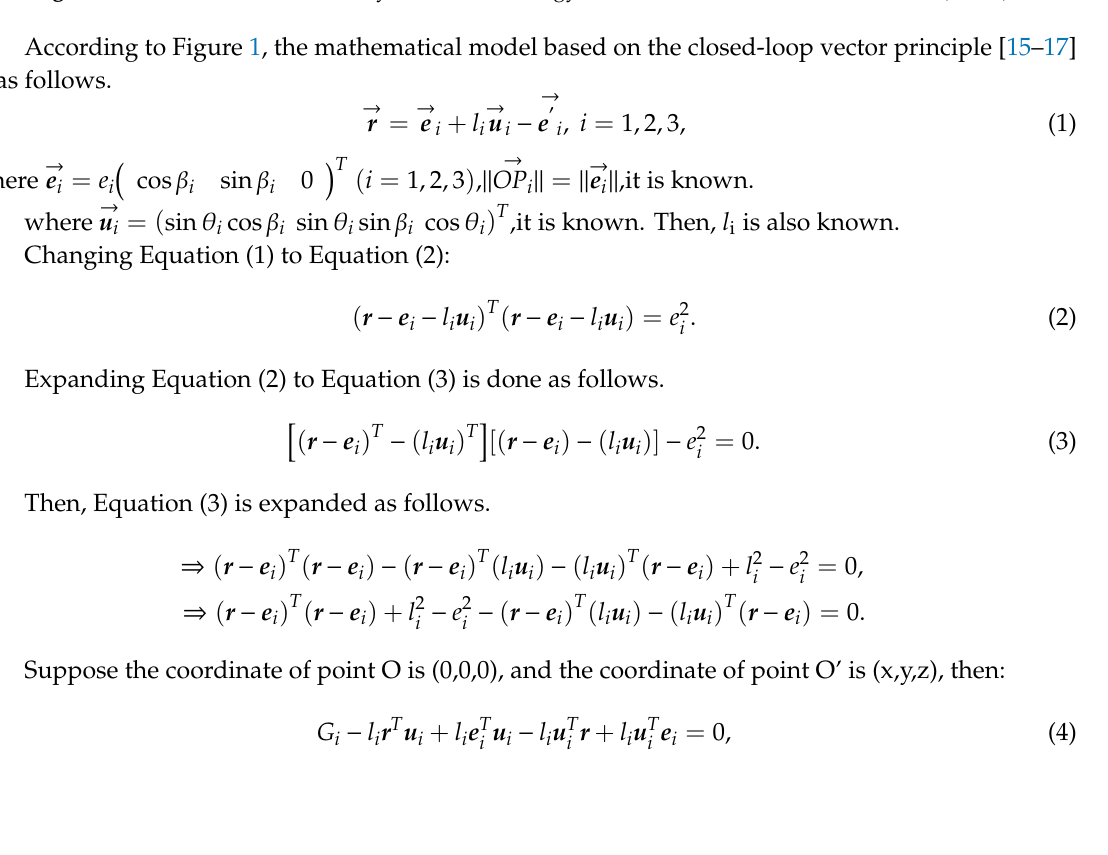
Figure 1. mathematical model of Synthesis Technology of Multi-Path Laser Interferometers (SMLI). Figure 1. Mathematical model of Synthesis Technology of Multi-Path Laser Interferometers